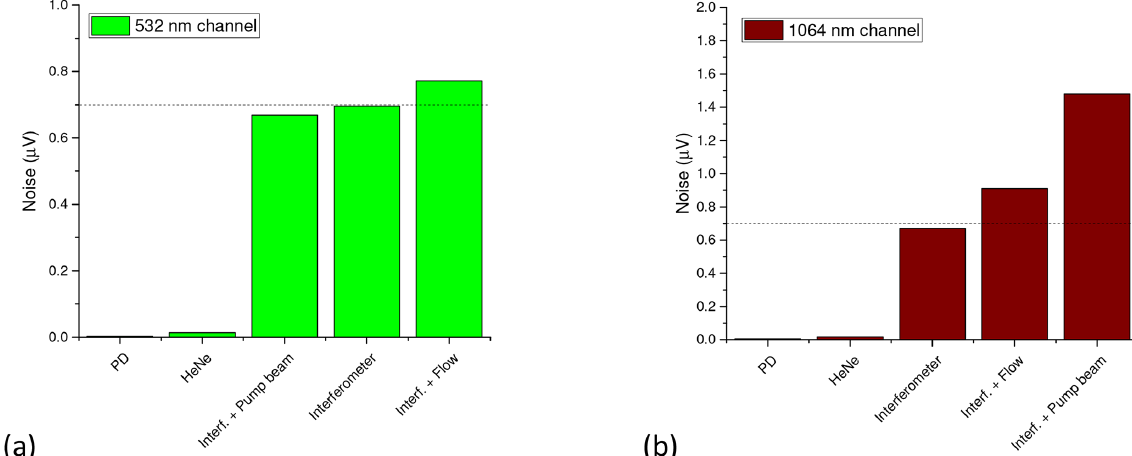
Figure 5. Contribution of different sources to the measurement noise (standard deviation of signal) for the 532nm channel (a) and the 1064nm channel (b) run at 91 and 96Hz, respectively. Settings: “PD” – photodiode noise, “HeNe” – noise of the HeNe laser (blocked one of the interferometer arms), “Interferometer” – noise of the interferometer, “Interf. + Flow” – interferometer noise for sample flow switched on and “Interf. + Pump beam” – interferometer with a pump beam switched on.